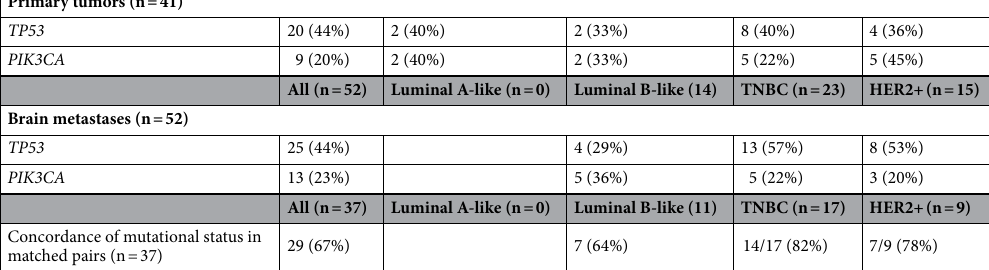
Table 4. Survival parameters of the 57 patients with brain metastases analyzed with